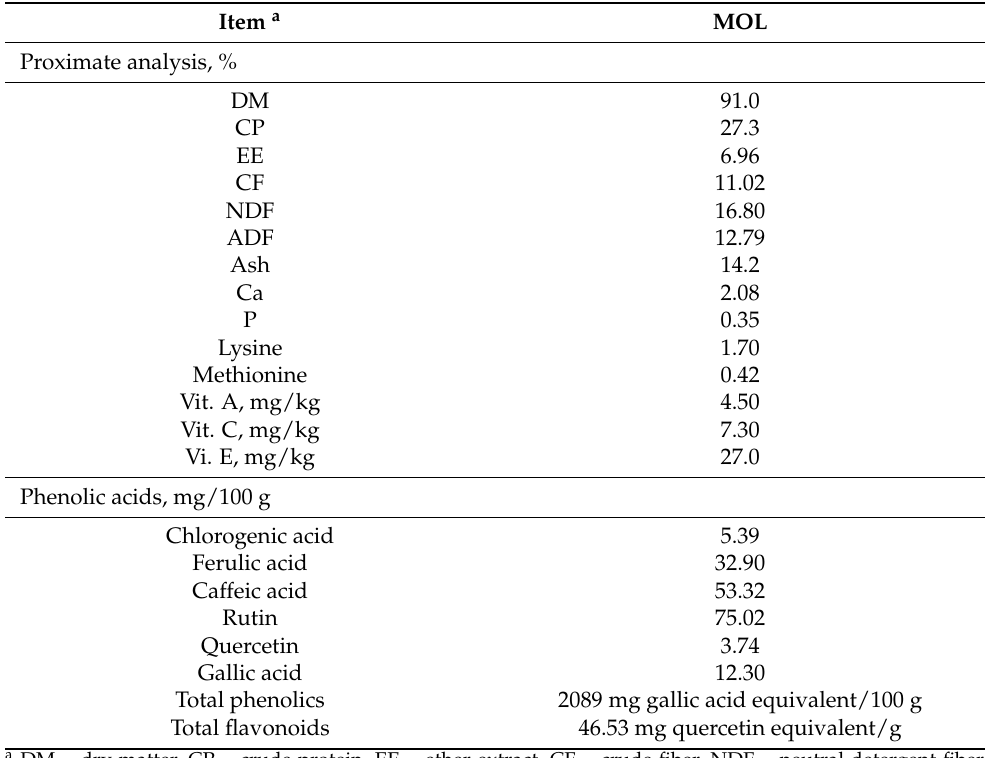
Table 1. Nutrients and phenolic acids content of M. oleifera leaves (MOL) as DM basis. Item a MOL Proximate analysis, % DM